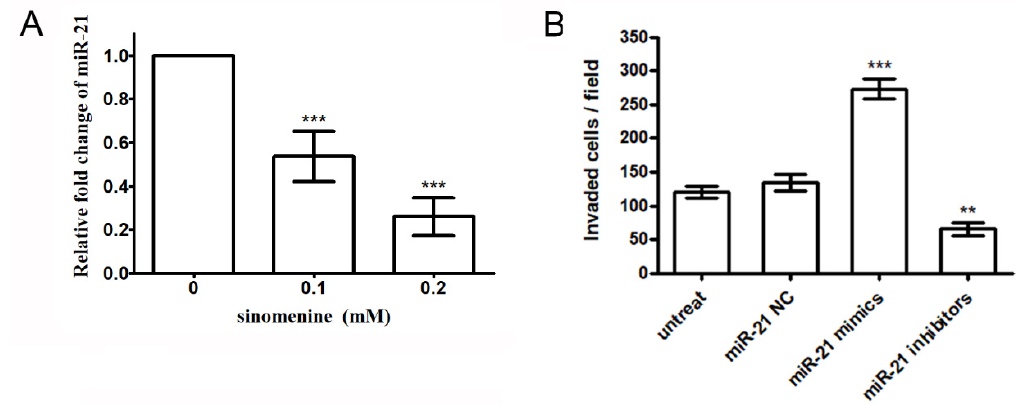
Figure 5. E ff ects of sinomenine on the expression of miR-21. ( A ) Cells were treated with various concentrations of sinomenine for 24 h and the expressions of miR-21 were analyzed by quantitative real-time PCR. ( B ) A549 cells were transfected with the miR-21 negative control (miR-21 NC), miR-21 mimics, or mir-21 inhibitors for 48 hrs. Cell invasion was performed by Boyden chamber invasion assay. Data are expressed as mean ± S.D. of three independent experiments. ** p < 0.01, *** p < 0.001 compared with the untreated control.